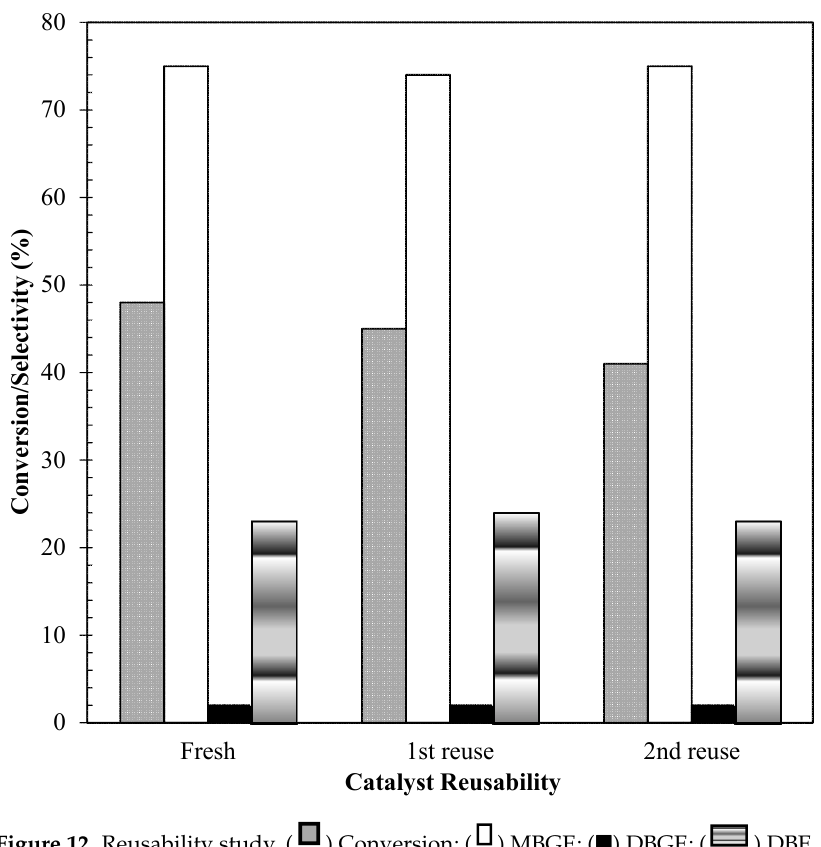
Figure 12. Reusability study